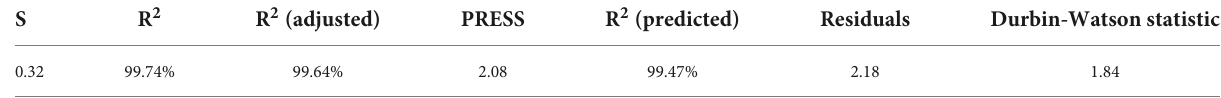
TABLE 7 Model summary of SMLR under cauliflower-cowpea-okra cropping system.